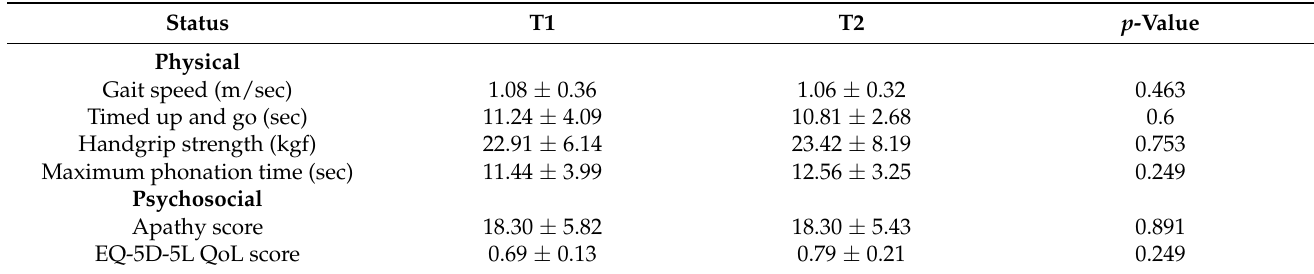
Table 1. Physical and Psychological Status in the Male